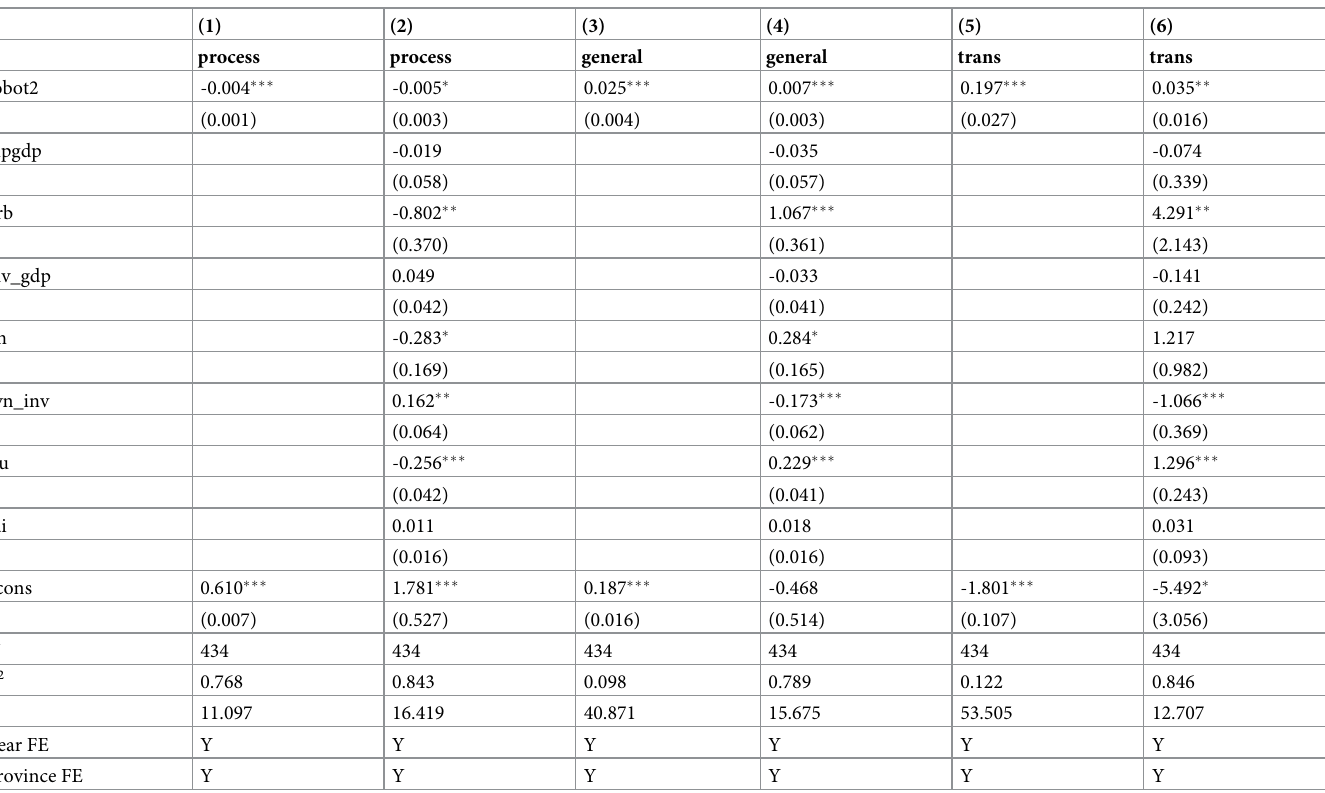
Table 3. Robustness test